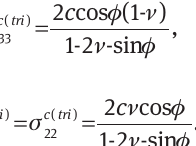
Figure 2D. Haberl et al. [25, 26] also studied the defor- mation behavior of ion-implanted unrelaxed a-Si thin films consisting dangling bond defects under spherical nanoindentation at room temperature. For more details